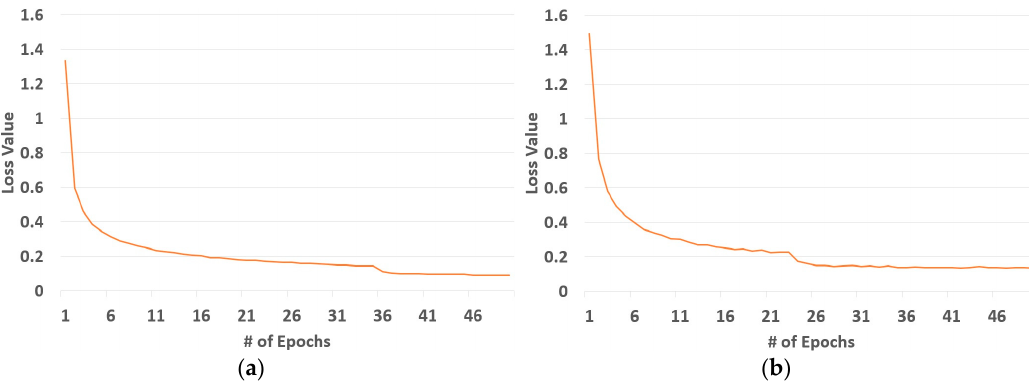
Figure 9. Convergence graphs depicting losses from the training process. ( a ) First set. ( b ) Second set.